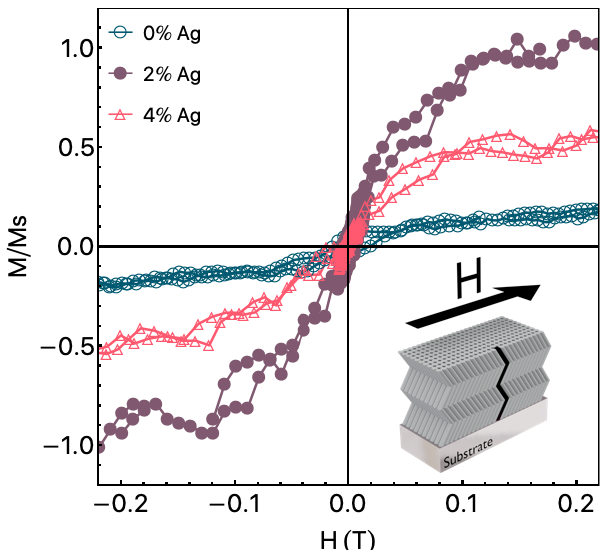
Figure 3. Normalized magnetization curves for the ZnO film and the Ag-doped ZnO films. The mag- netization curves are normalized by the saturation magnetization obtained for the ZnO:2Ag film. The inset depicts the field applied direction during the magnetization